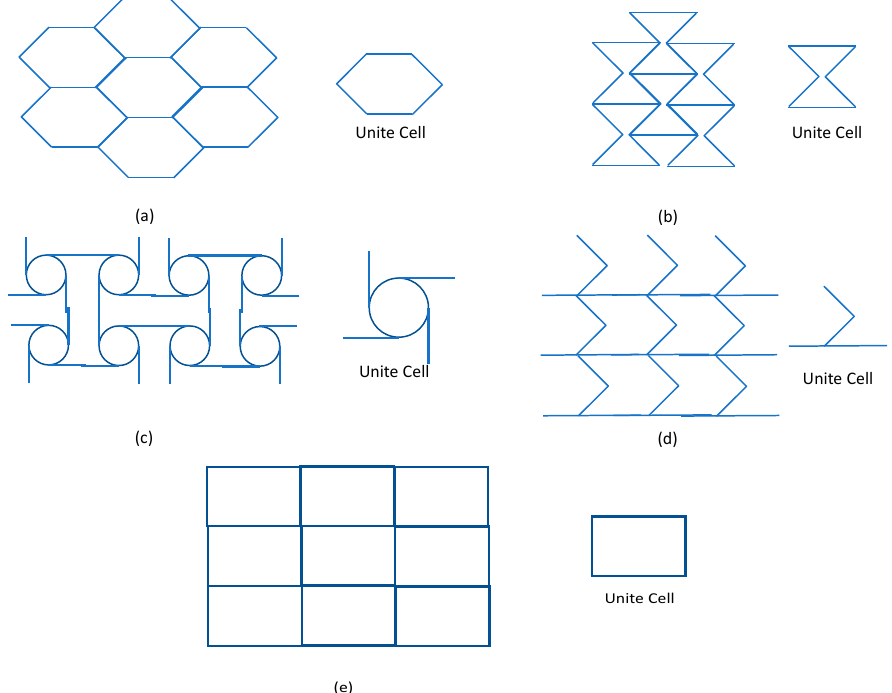
Figure 6. A sample lattice structures, unit cell of ( a ) honeycomb, ( b ) auxetic, ( c ) chiral, ( d ) zero Poisson’s ratio honeycomb, and ( e ) square lattices.